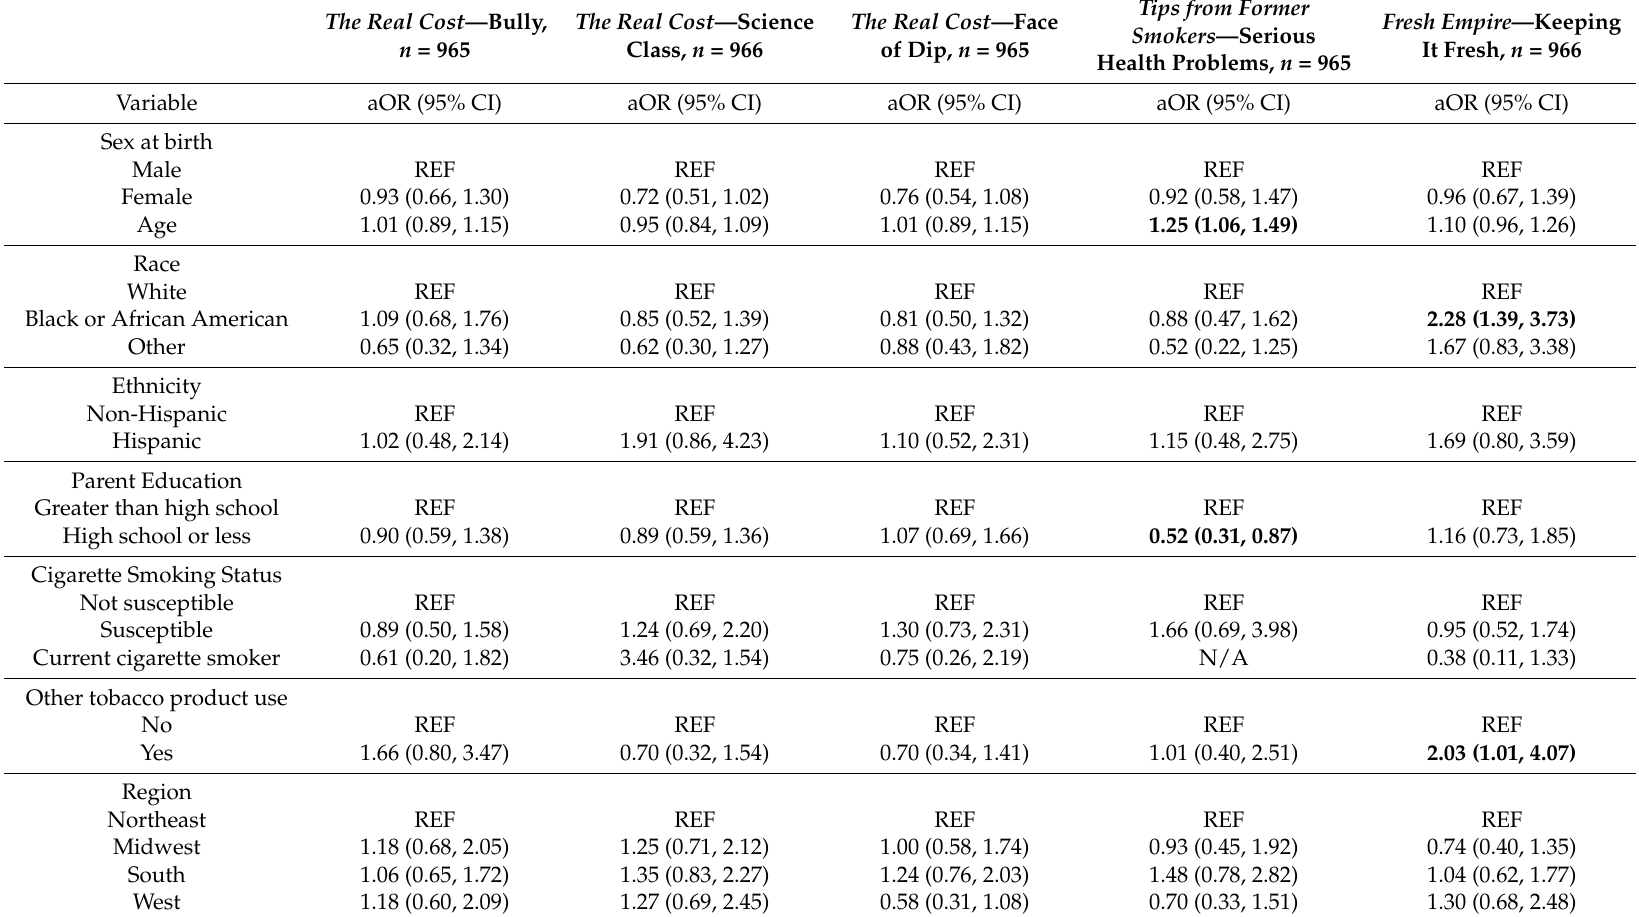
Table 3. Weighted logistic regression results for aided recall of the five ads from a national sample of adolescents, conducted by the Carolina Survey Research Laboratory from August 2016 to May 2017 1